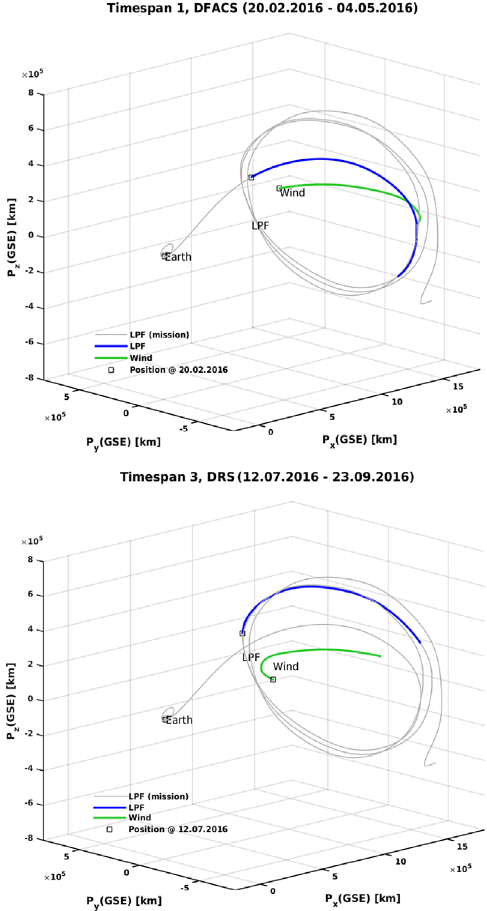
Figure 8. LPF and Wind orbits during the timespans indicated with TS1 and